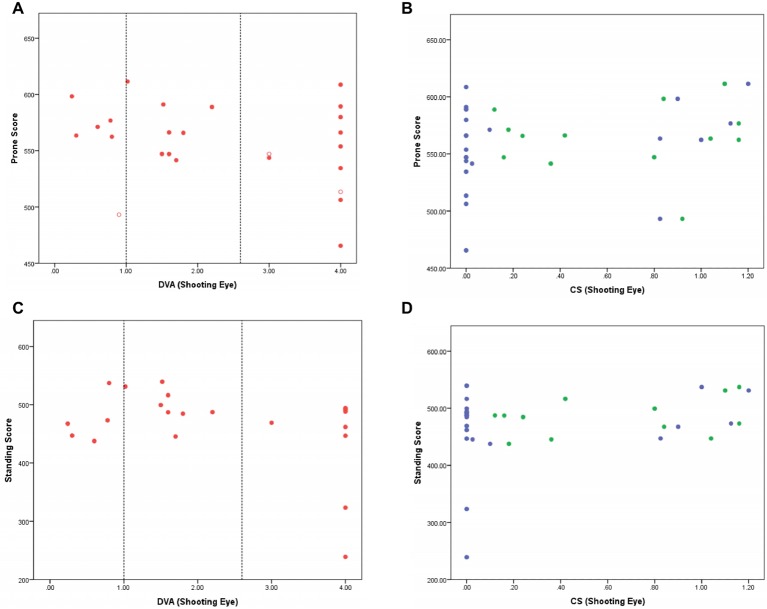
(A–D) Shooting score in the prone (A,B) and standing (C,D) competitions are shown as a function of distance VA (A and C; red) and CS (B and D; green for Pelli Robson test and blue for Mars test) of the shooting eye. Closed symbols indicate athletes who shot in both prone and standing competitions. Open symbols indicate athletes who shot in the prone competition only. In the VA figures (A,C), vertical lines indicating 1.0 logMAR (current minimum entry criterion to VI shooting) and 2.6 logMAR [poorest vision measureable with the BRVT; above this level athletes have PL (assigned 3 logMAR) or NPL (assigned 4 logMAR)] are shown. Young adults without VI typically score 0.00 logMAR. In the CS figures (B,D), participants with no measurable function have a score of 0.00 logCS. Young adults without VI typically score 1.70 logCS units.